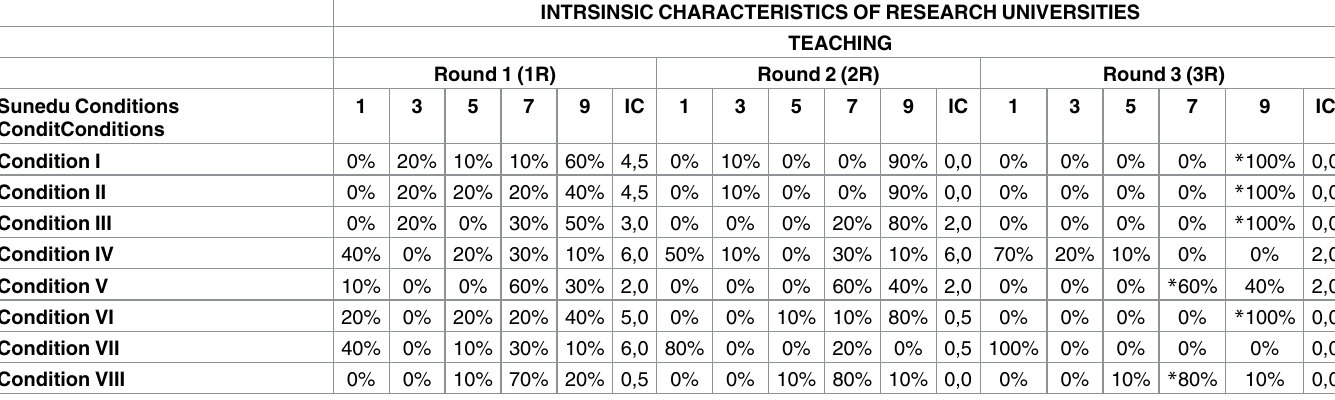
Table 2. Results of the Sunedu-Teaching conditions.